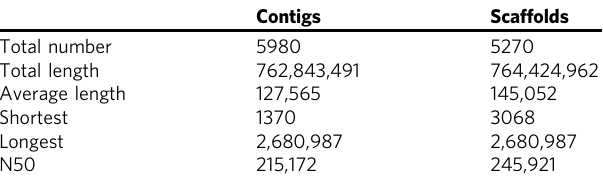
Table 2 Characteristics of Mlig_3_7 genome